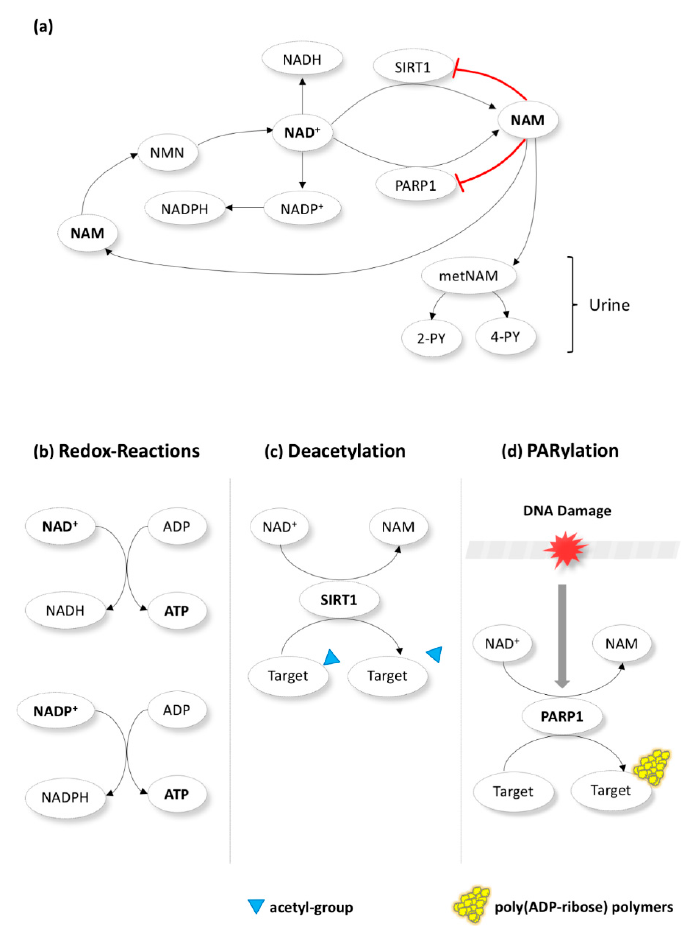
Figure 1. Nicotinamide (NAM) metabolism. NAM is a precursor of nicotinamide-adenine dinucleotide (NAD + ) and regulates cellular metabolism. NAM is first converted to NMN (nicotinamide mononucleotide) in the cytoplasm before becoming NAD + . The latter acts a co-enzyme in redox reactions ( b ) that produce adenosine triphosphate (ATP) or is phosphorylated towards NADP + (which also takes part in redox reactions). Additionally, NAD + is a substrate for enzymes in non-redox reactions, where it is cleaved back to NAM ( a ). The most well-studied enzymes in these reactions are the sirtuin 1 (SIRT1) and the poly ADP-ribose polymerase 1 (PARP1). SIRT1 and PARP1 carry out the protein posttranslational modifications called deacetylation ( c ) and poly(ADP- ribosyl)ation (PARylation)( d ). Notably, while SIRT1 and PARP1 are activated by NAD + ( c ) and DNA damage ( d ), respectively, NAM suppresses both through a negative feedback mechanism ( a ). NAM produced in non-redox reactions could “go back” to be converted once more to NAD + via NMN. Alternatively, it could be metabolized to metNAM (methyl-NAM) and subsequently to 4-PY (N-methyl-2-pyridone-5-carboxamide) and excreted through the urine ( a